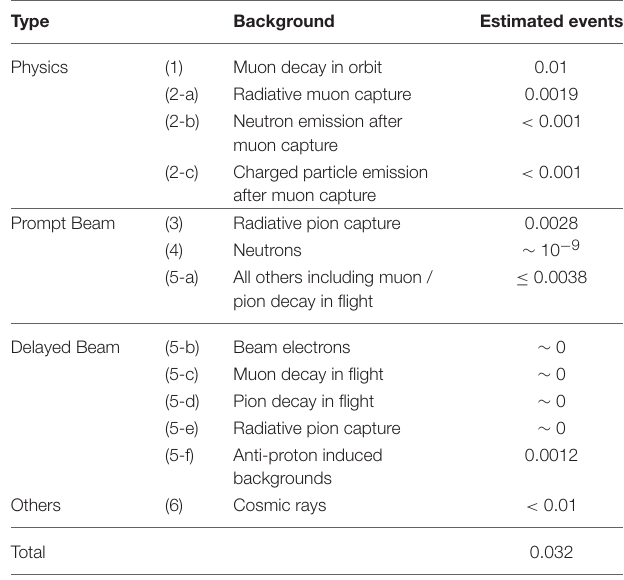
TABLE 4 | Summary of the estimated background events for a single-event sensitivity of 3 × 10 − 15 in COMET Phase-I with a proton extinction factor of 3 × 10 − 11